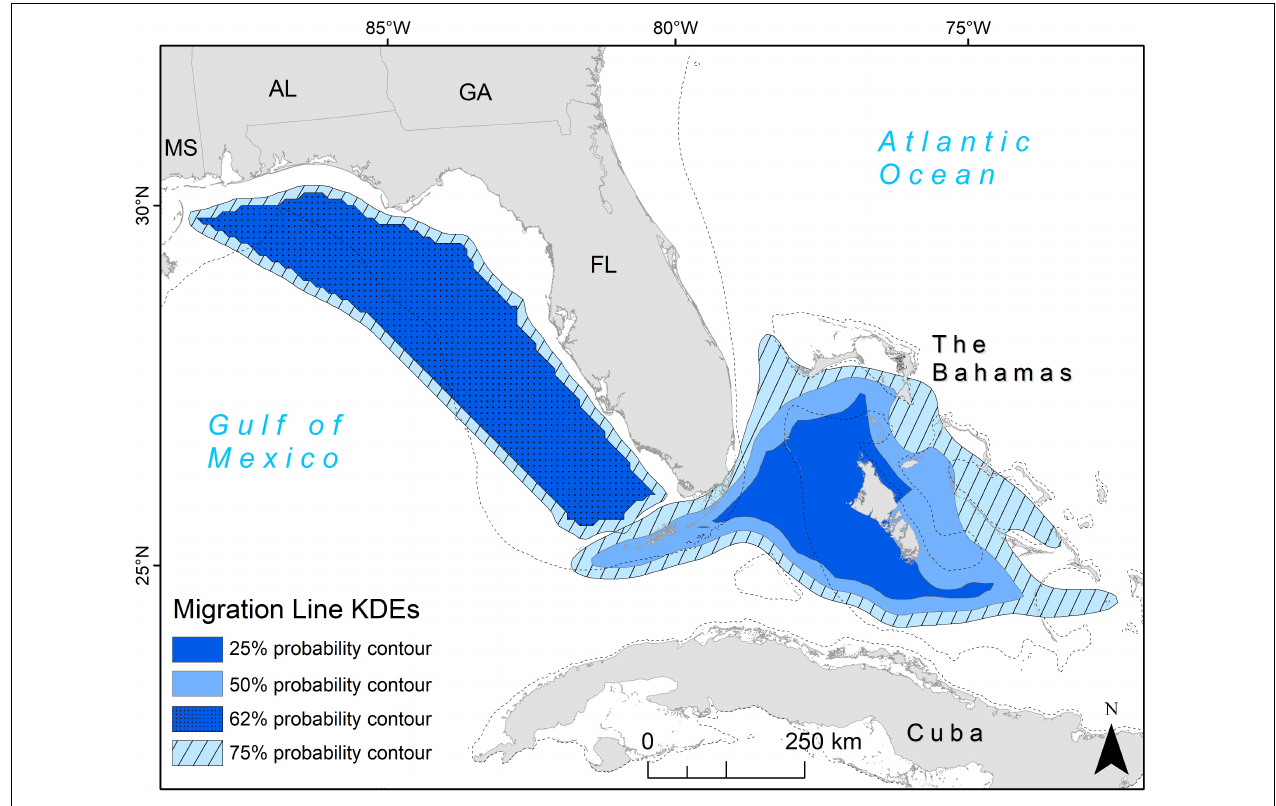
FIGURE 2 | Migration line kernel density estimates (KDEs) for adult female loggerhead sea turtles ( Caretta caretta ; 64 tracks). Two migration corridors were identified: in the eastern Gulf of Mexico and the Florida (FL) Straits into the Bahamas. The KDEs were based on multiple tracks in the Gulf of Mexico ( n = 37) and FL Straits ( n = 27). Values represent probability that a migrating animal will be found in each contour. U.S. states are abbreviated: MS, Mississippi; AL, Alabama; GA, Georgia; FL, Florida. The 200 m bathymetric contour is shown as a dashed